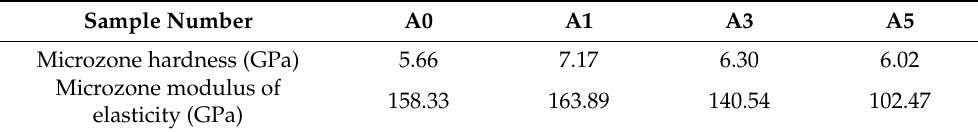
Table 3. Microzone hardness and microzone elastic modulus of different samples.